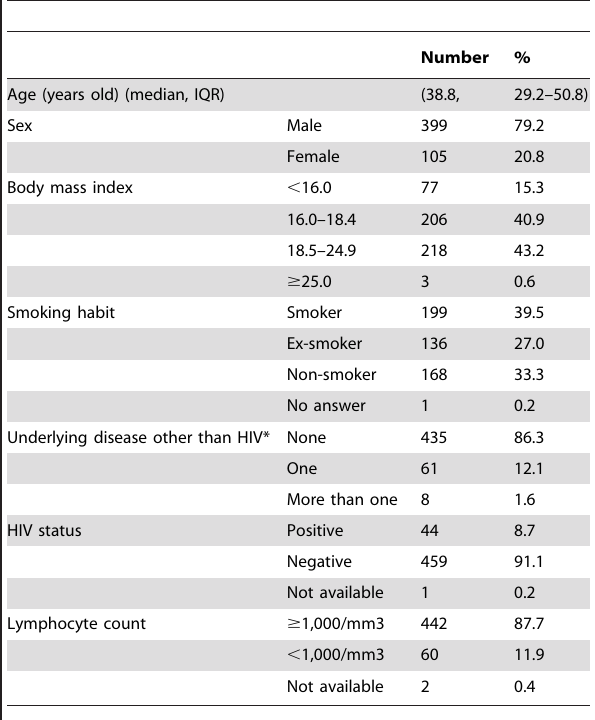
Table 1. Characteristics of patients with smear-positive/ culture-positive pulmonary tuberculosis (n=504).